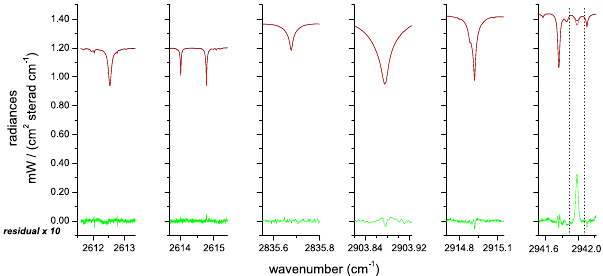
Figure 3. Spectral microwindows applied to retrieve the tropo- spheric CH 4 mole fraction. It shows measured spectrum (black), simulated spectrum (red), and residuals multiplied by a factor of 10 (green). The black dashed lines in the last microwindow delimit an absorption line that is not included in the retrieval